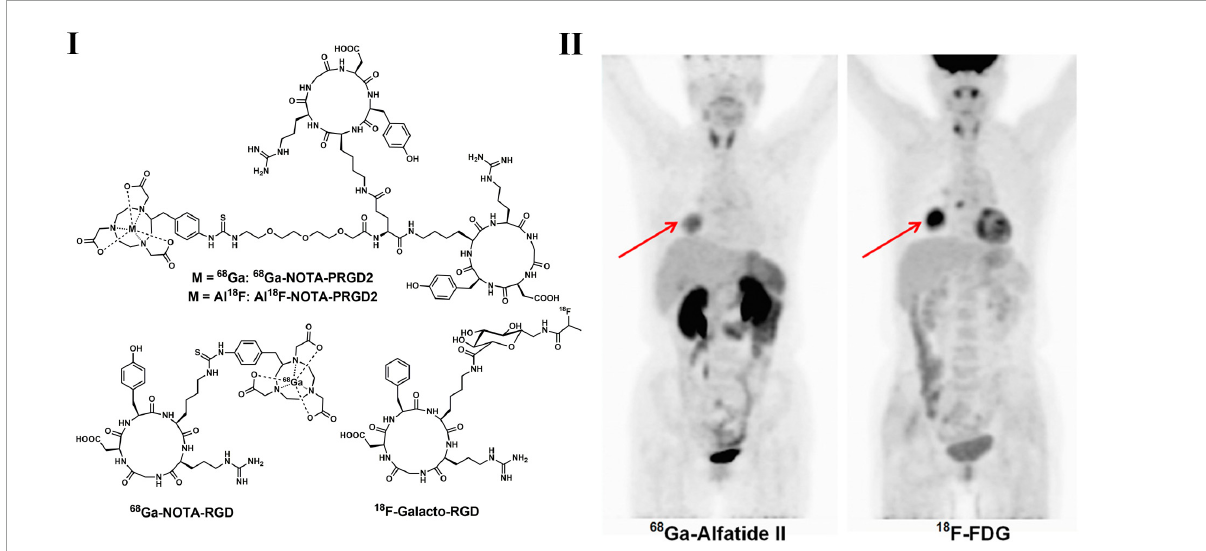
FIGURE3 Structures of representative angiogenesis PET tracers (I) and PET images of 68 Ga-Alfatide (II) ( 68 Ga-NOTA-PRGD2) and 18 F-FDG in patient with representative squamous carcinoma (II)